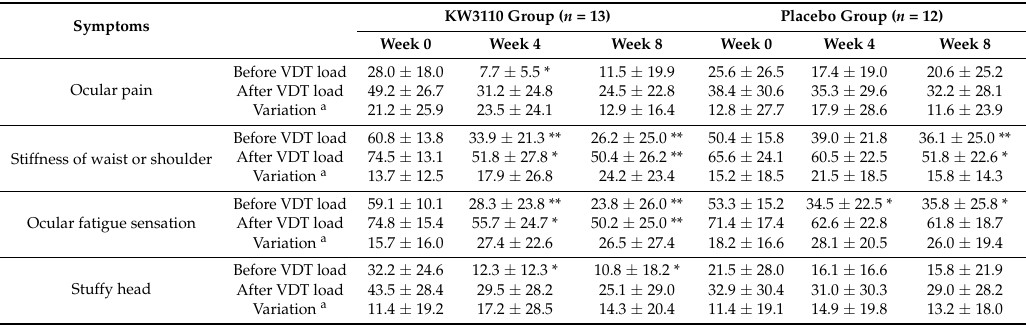
Figure 4. Changes in symptom scores of stiffness of the waist or shoulders from the values during week 0 in subjects with severe ocular fatigue sensation before the VDT load. VDT = visual display terminal. KW3110 = L. paracasei KW3110-treated group, placebo = control group. (* p < 0.05). Data are calculated as the degrees of change from the values during week 0. The comparisons between two groups at each time point were performed by an unpaired Student’s t -test with a Holm correction for multiple comparisons (* p < 0.05 versus placebo). Data are shown as the means ± SE. KW3110 = L. paracasei KW3110-treated group, placebo = control group.